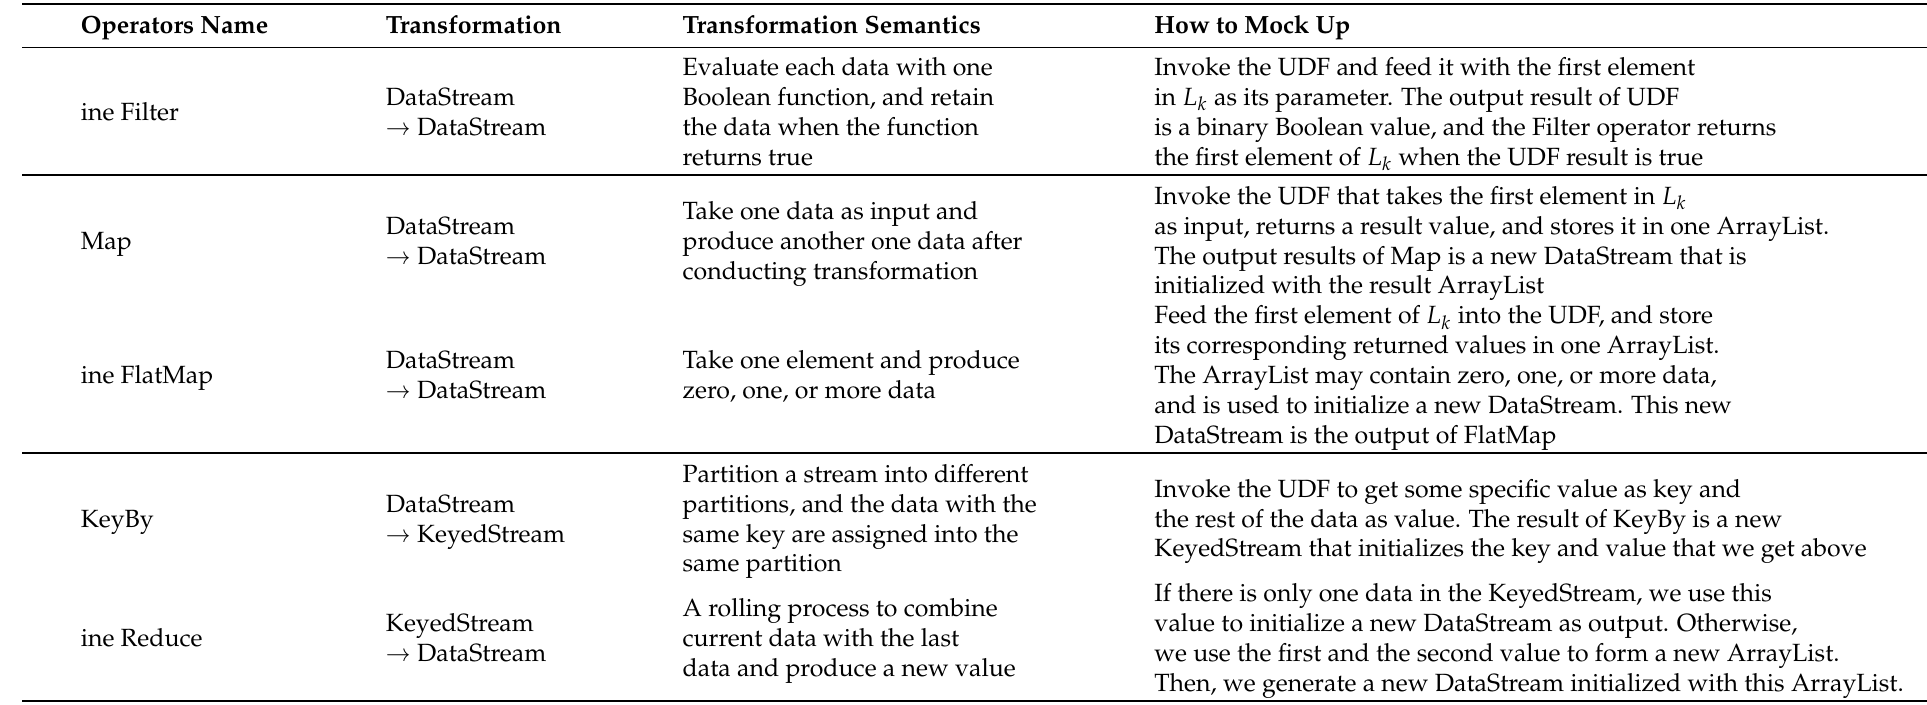
Table 1. The representative operators in most DSP